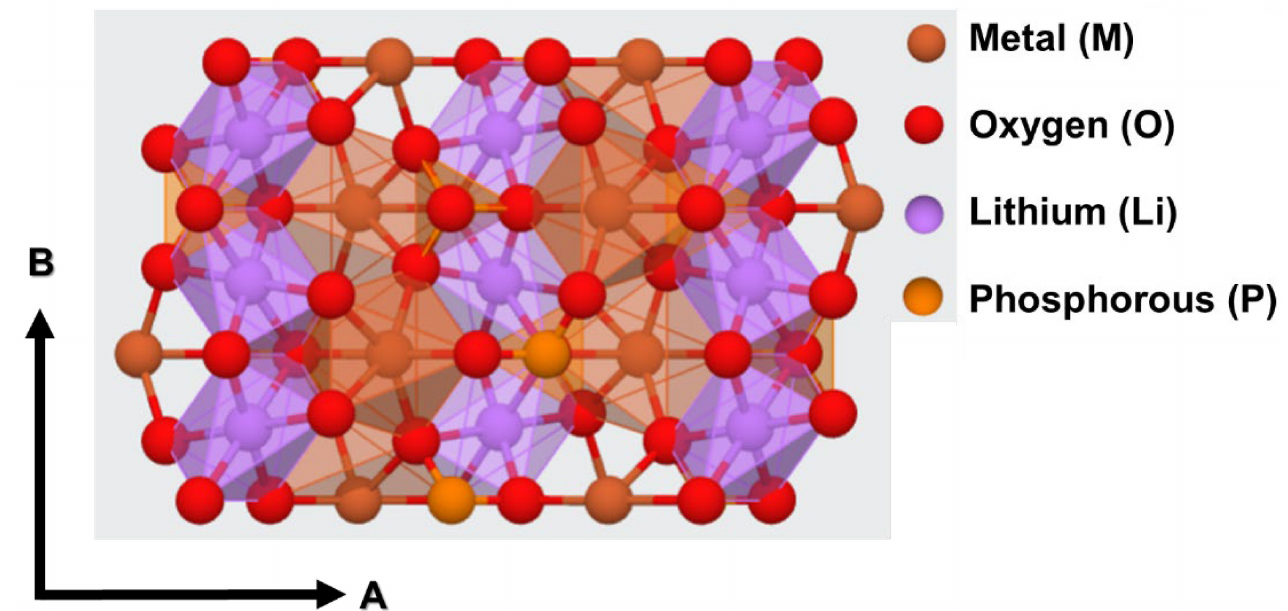
Figure 2. Schematic representation of the generic structure of LiMPO 4